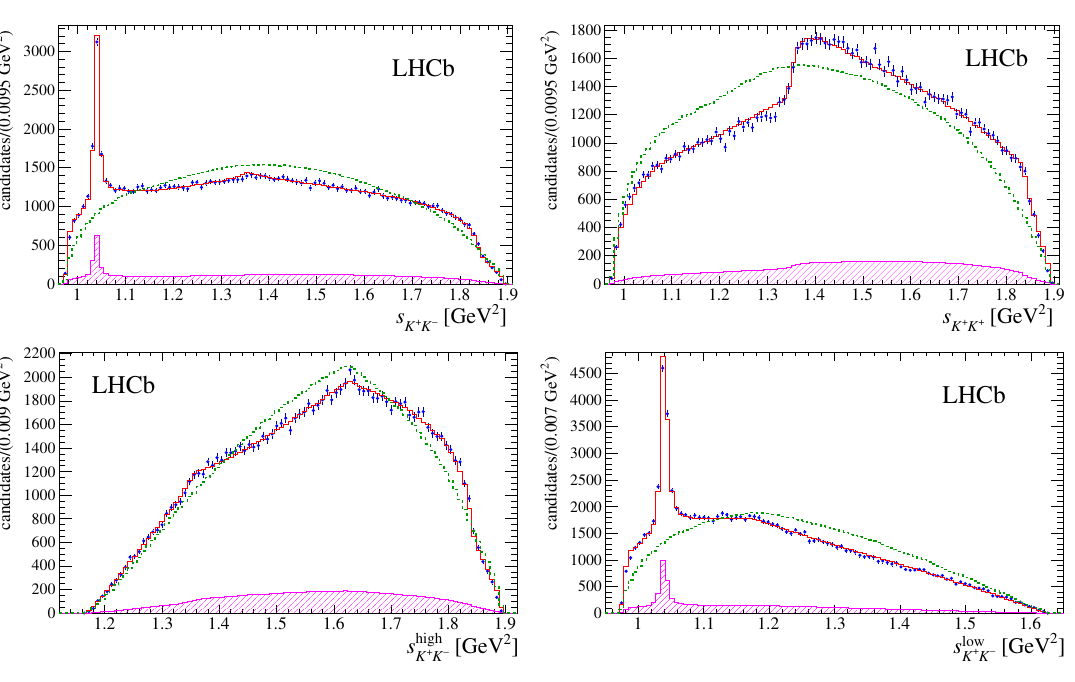
axes, with the (cid:12)t result with model A overlaid (red K + K (cid:0)